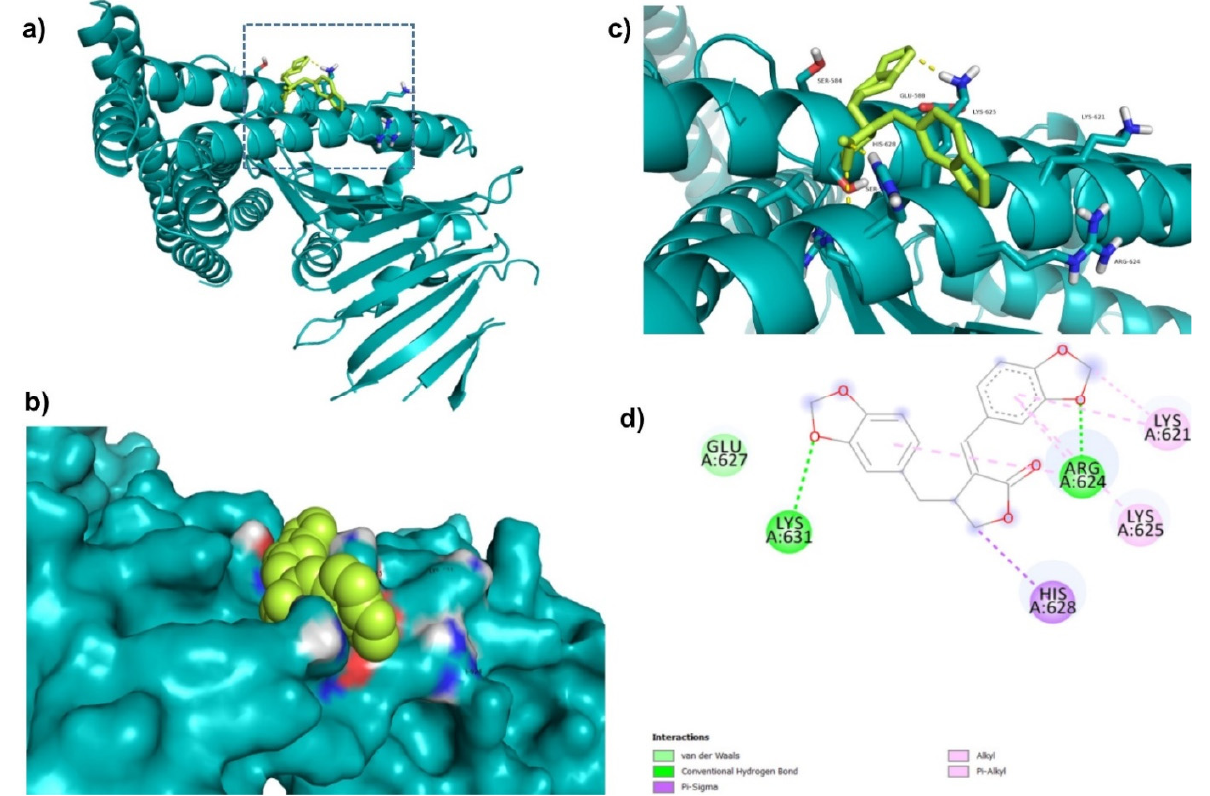
Figure 3. Visualization and surface view of ZINC164387 in active site of CagA protein ( a , b ). Three- dimensional ( c ) and 2D ( d ) view of CagA residue interacting with ZINC164387.